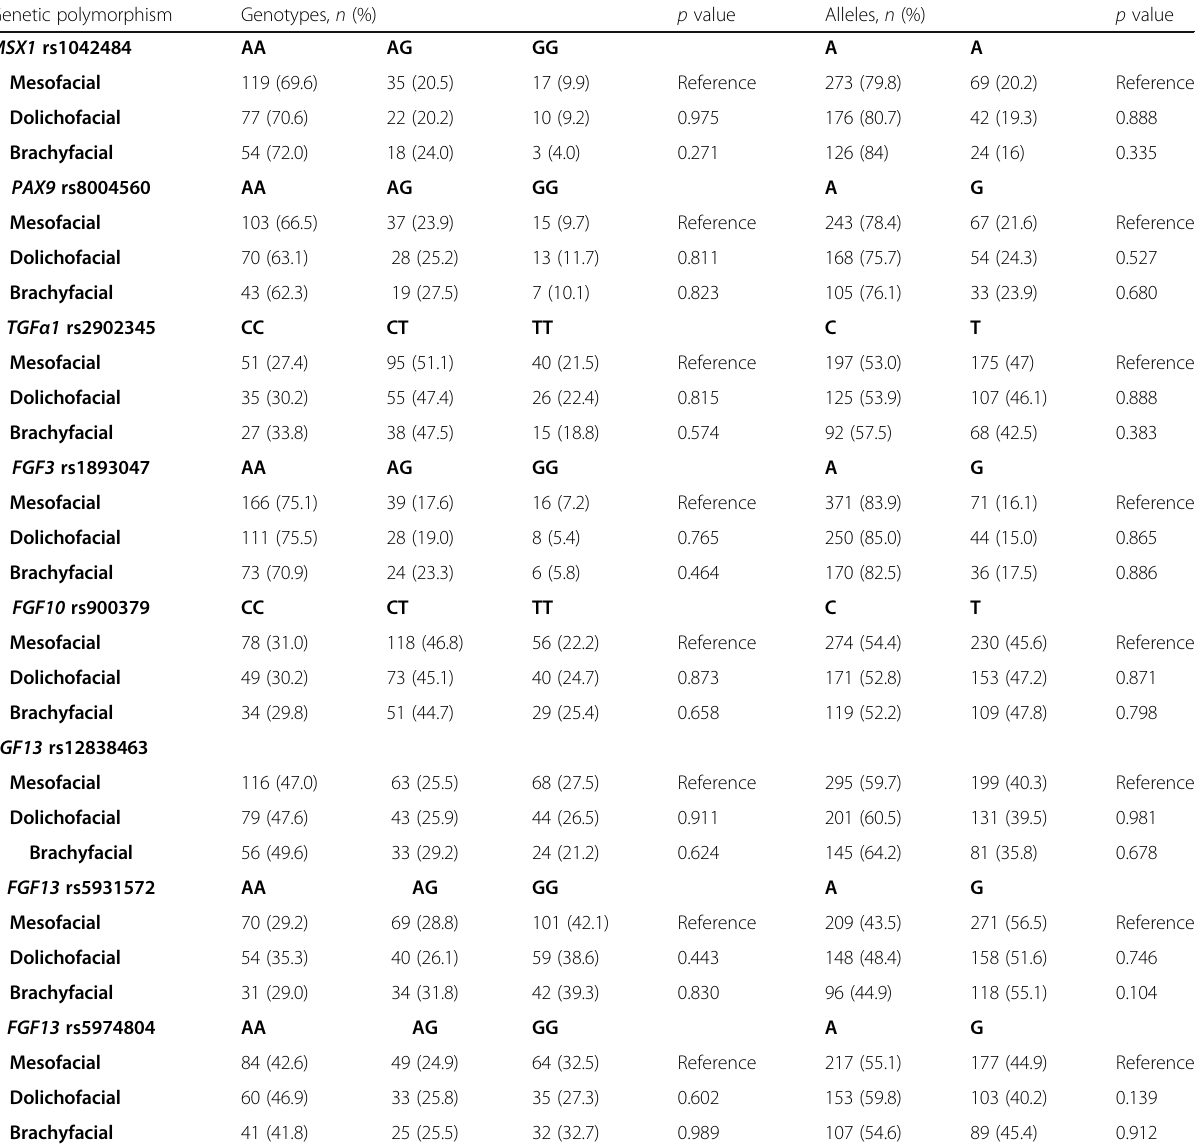
Table 4 Genotype and allele distribution among mesofacial, dolichofacial, and brachyfacial growth patterns Genetic